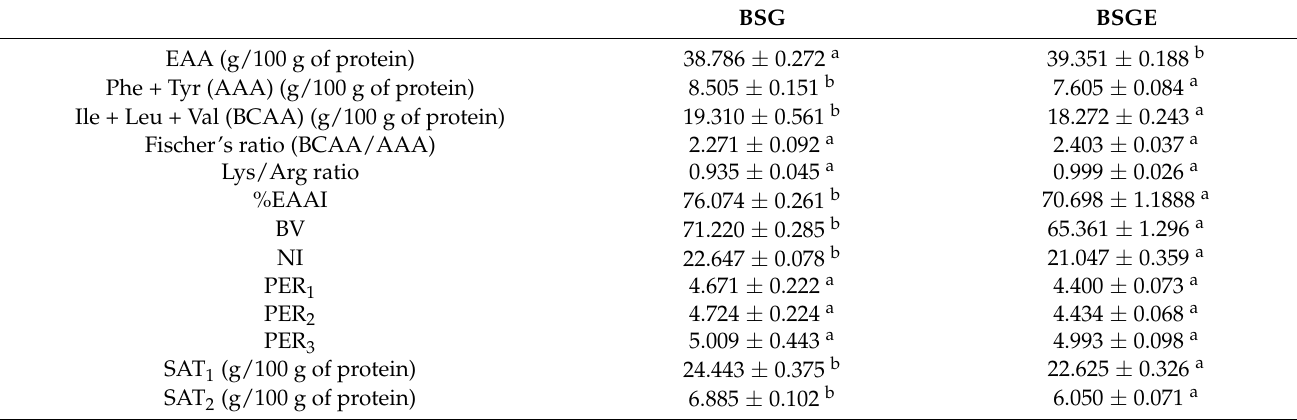
Table 5. BSG and BSGE’s nutritional protein quality parameters. BSG